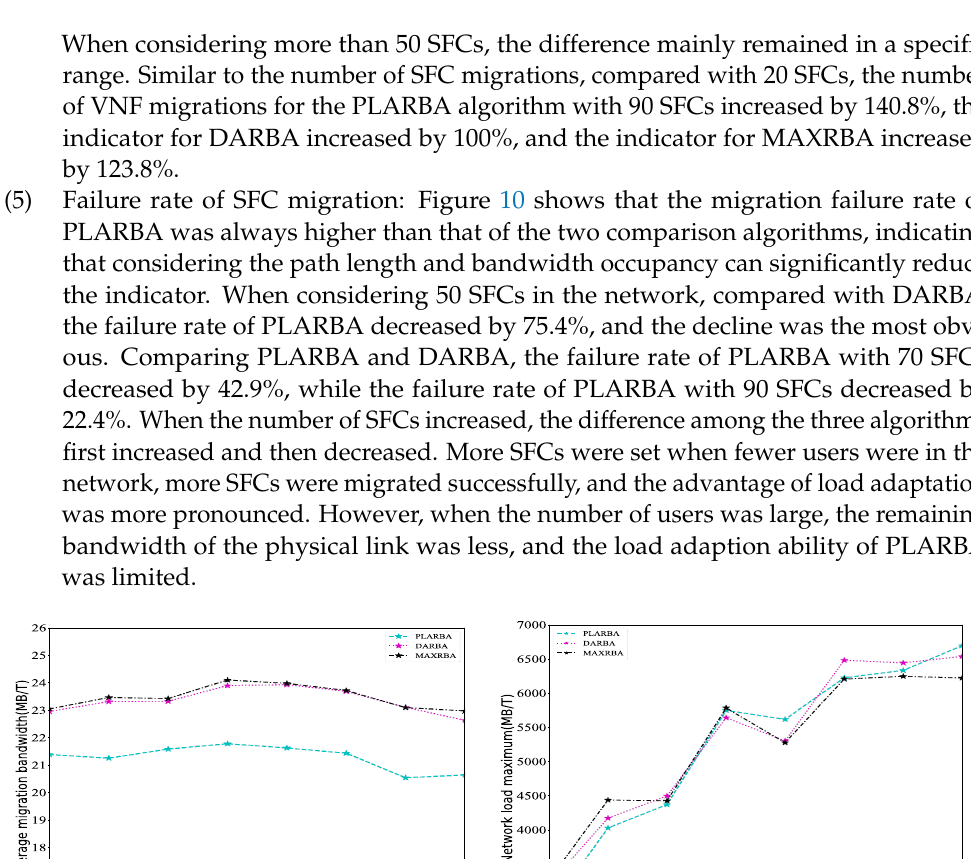
Figure 10. Failure rate of SFC migration with respect to SFC numbers. According to the experimental simulation under a different number of users, PLARBA allocated the bandwidth dynamically according to the path load, allowing more SFCs to migrate successfully, while better utilizing network bandwidth and obtaining a